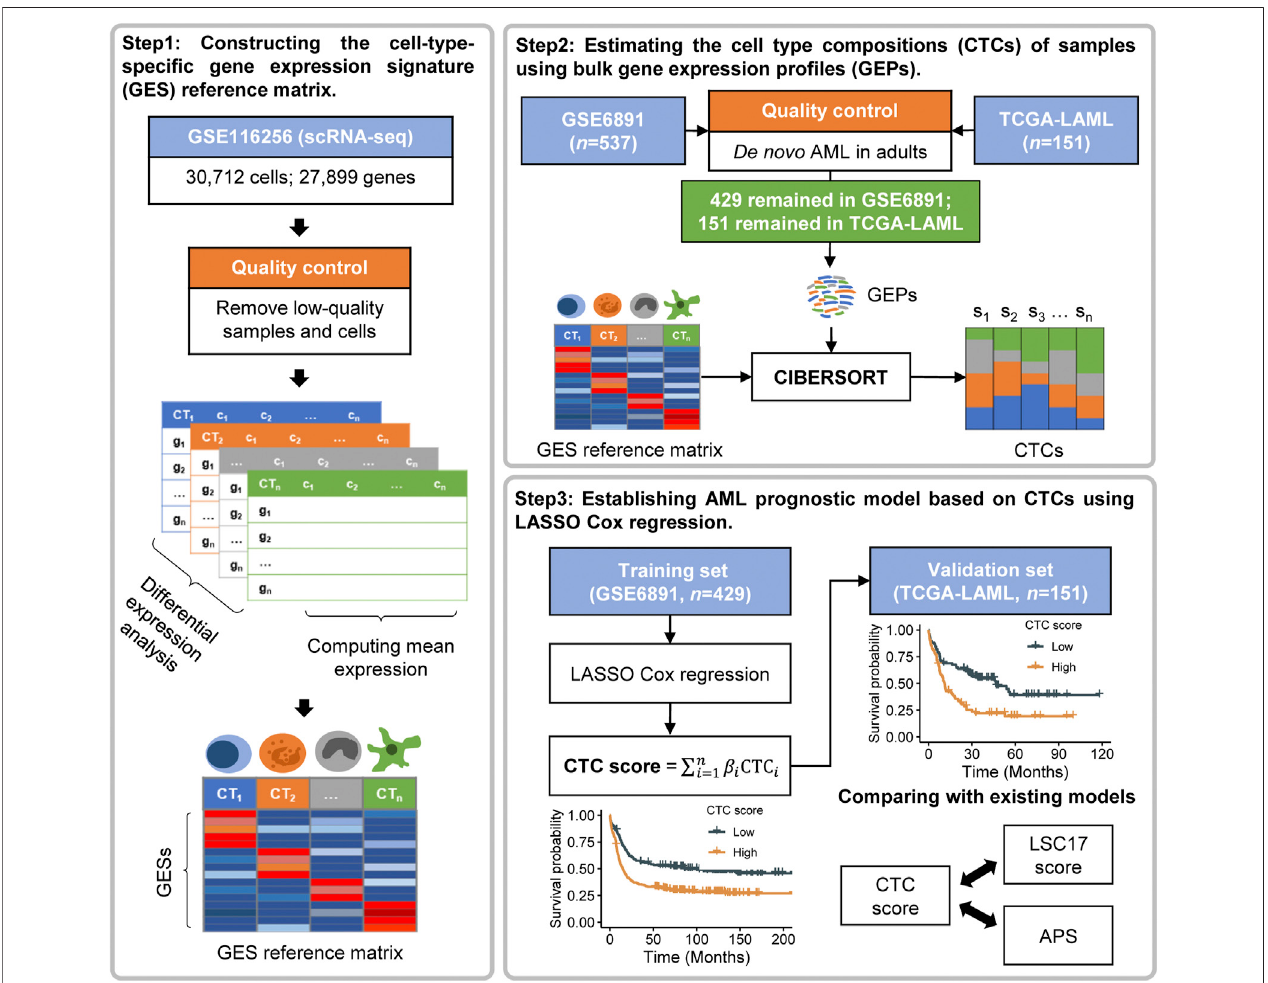
FIGURE 1 | Overview of the work fl